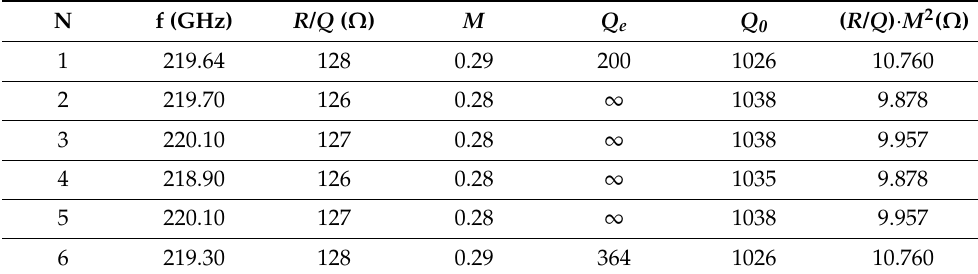
Figure 5. A 3D PIC simulation model of the complete EIK structure in CST. Table 3. Optimized parameters of each cavity for the